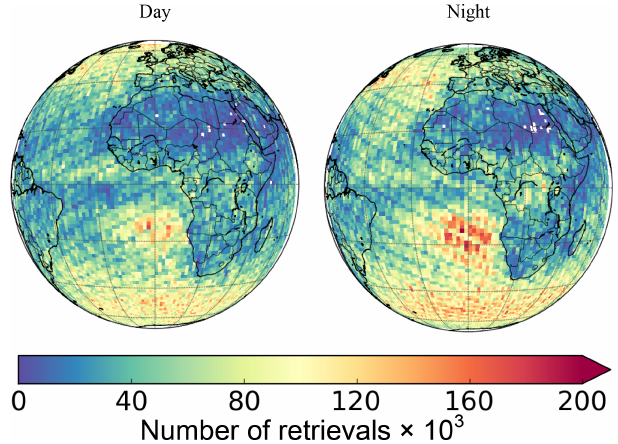
Figure 5. Spatial distribution of the number of collocated SEVIRI and CALIOP retrievals in 2007, shown separately for daytime and night-time